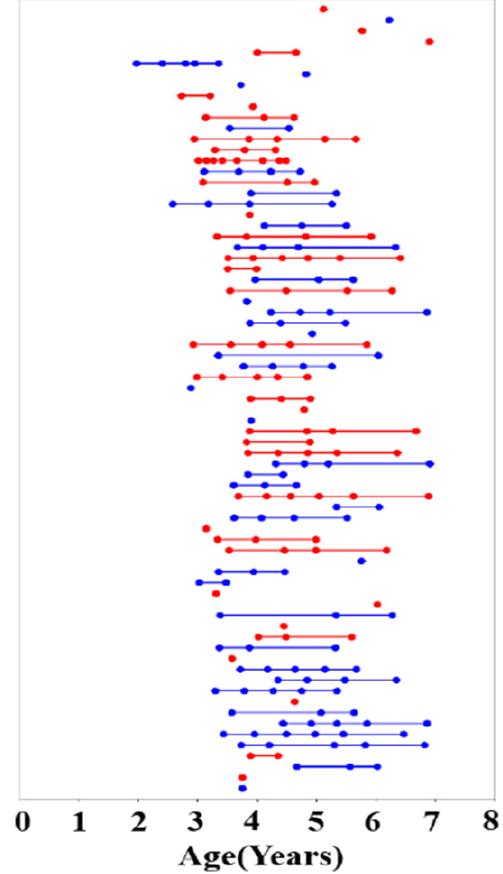
Figure 1. Age at time of scanning for 73 participants (red represents female, and blue represents male participants). Each scan is represented by a dot, and multiple scans on a given participant are connected by a straight line.